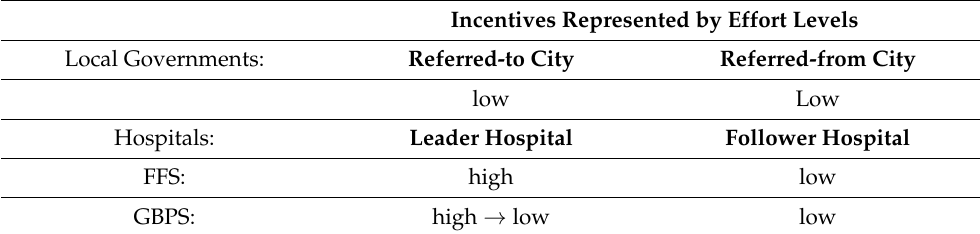
Table 3. Summary of incentive compatibilities and